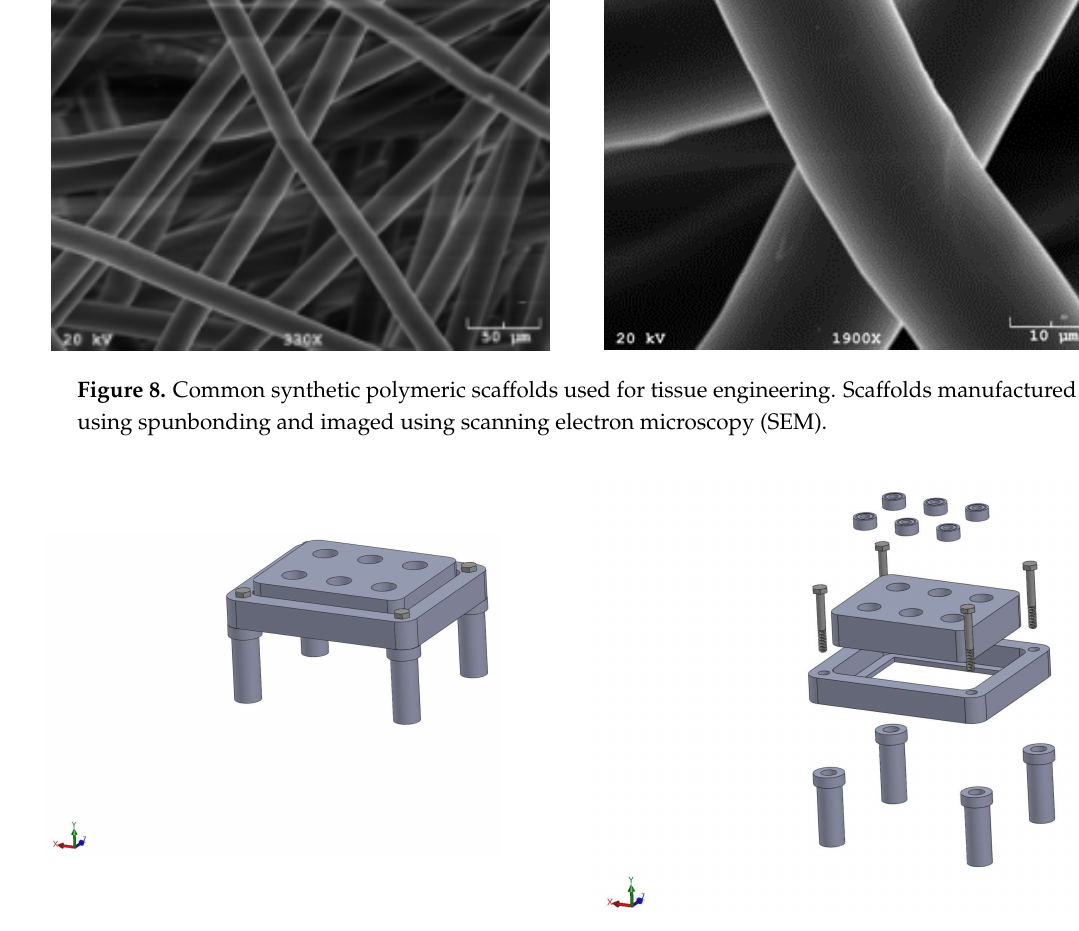
Figure 9. Schematic of the custom in-house perfusion bioreactor system. The right image shows the combination of the bioreactor body, scaffold cassettes and